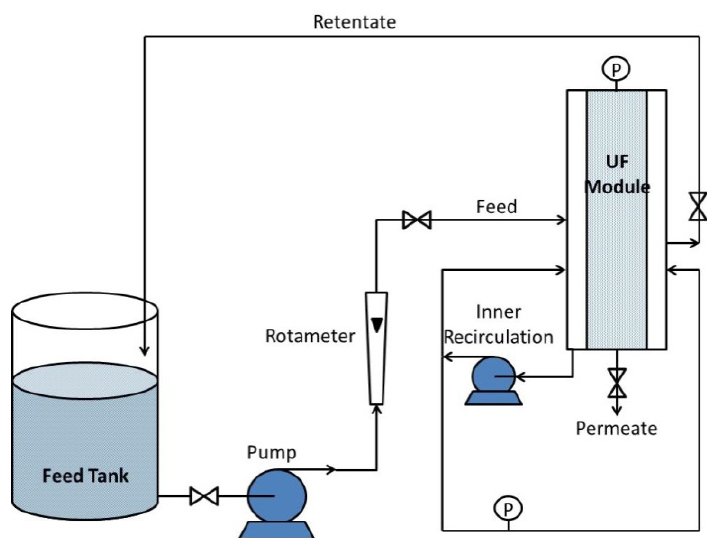
Figure 1. Schematic drawing of the 3DTA test membrane apparatus.